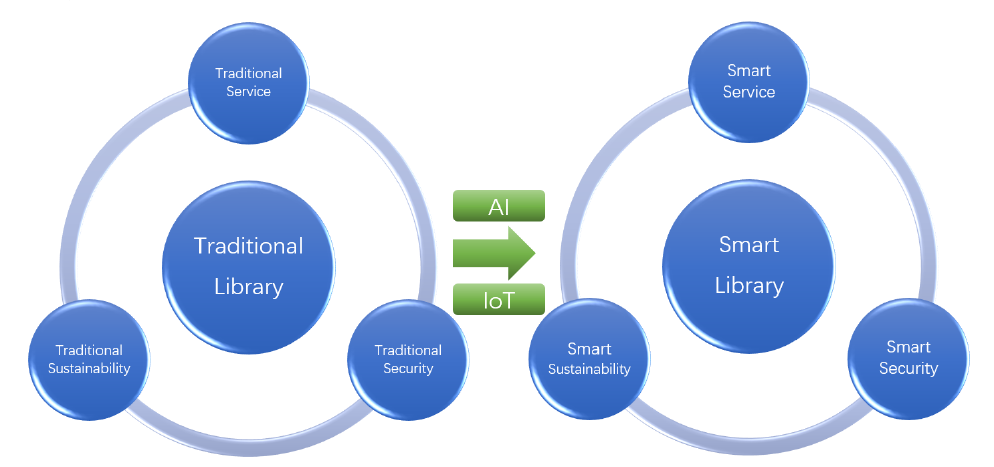
Figure 1. Transition from traditional to smart libraries via applying AI and